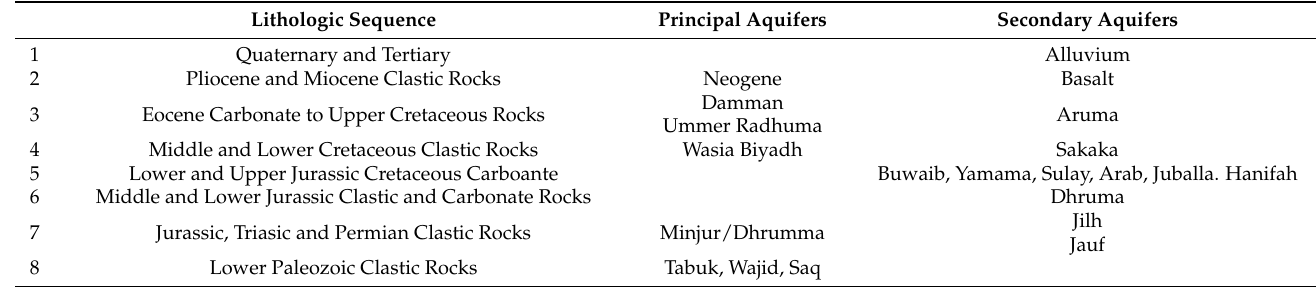
Table 1. Lithologic Sequence and Major Aquifers in Saudi Arabia